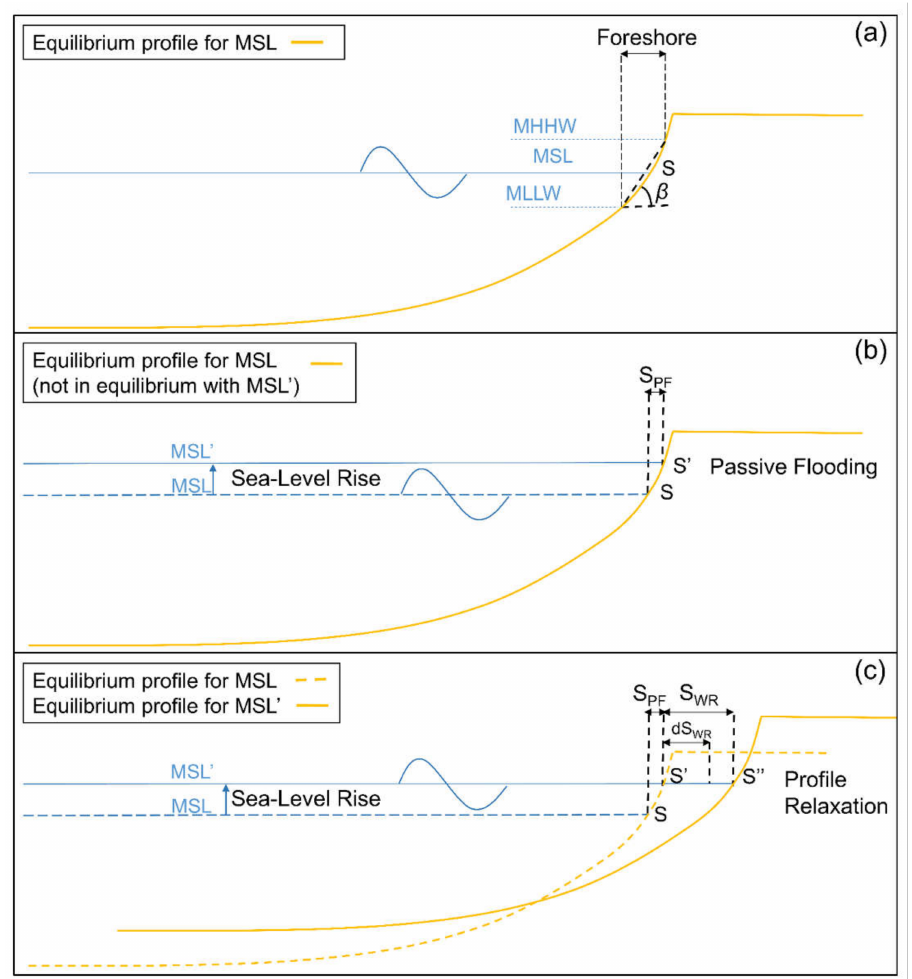
Figure 3. Scheme of the SLR-induced beach recession’s physical conceptualization: ( a ) theoretical equilibrium profile for the given mean sea-level, tide and wave conditions; ( b ) passive flooding of the profile for a given rise in sea level; ( c ) profile relaxation driven by wave action in response to the disequilibrium between wave climate and the profile in panel ( b ) with the new mean sea